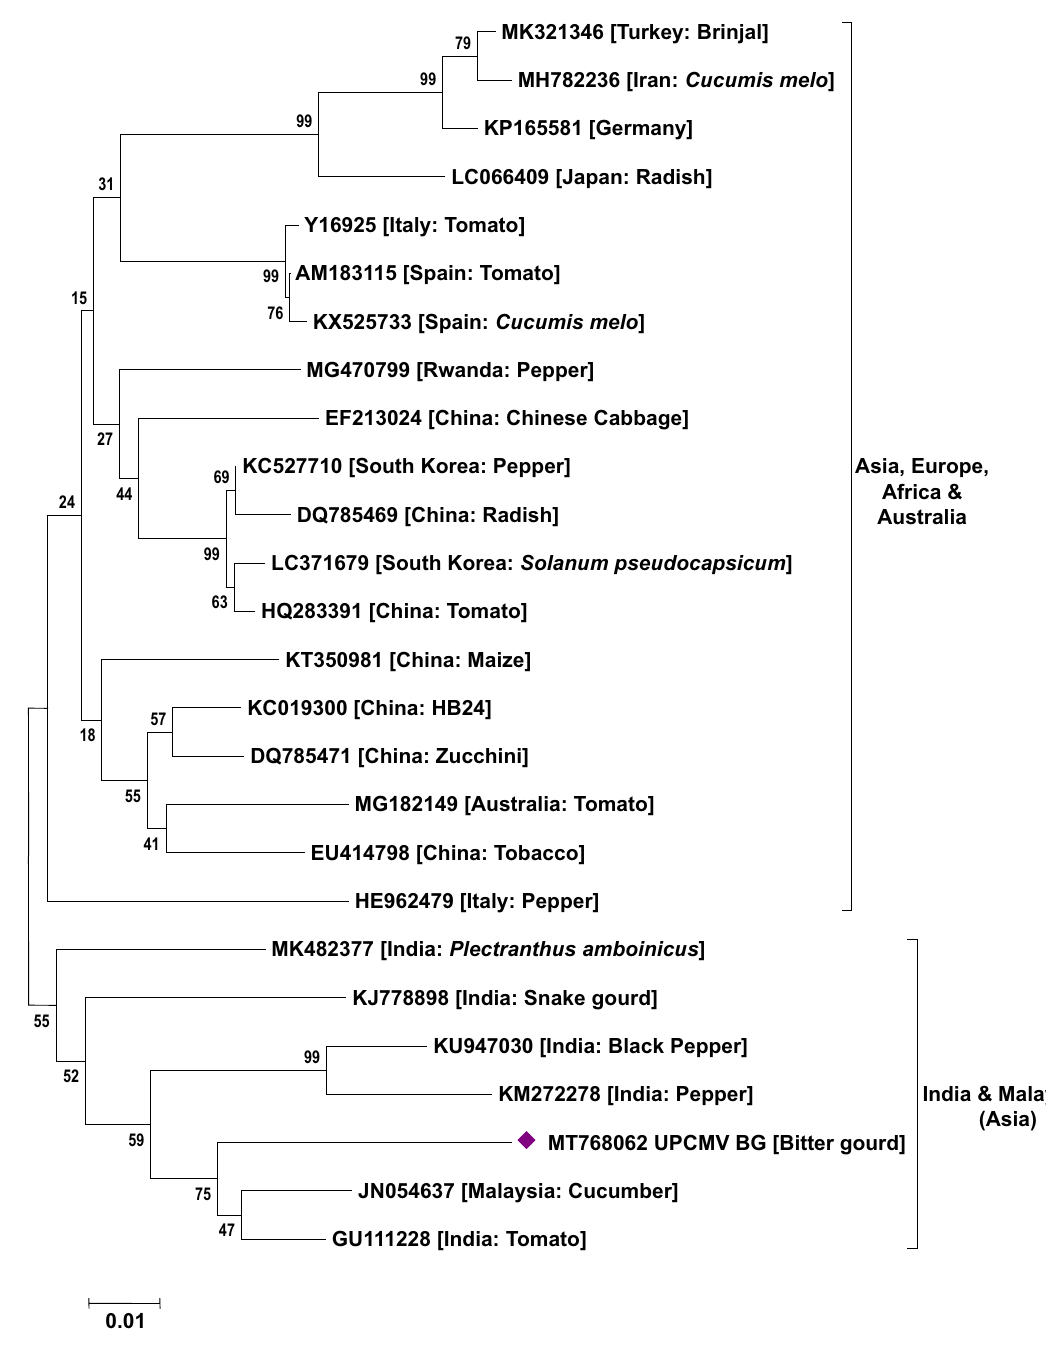
Figure 5. Phylogenetic analysis of ( a ) CMV infecting cucurbits in Uttar Pradesh state with other CMV isolates earlier reported based on 2a region. ( b ) CGMMV infecting cucurbits in Uttar Pradesh state with other CGMMV isolates reported earlier based on coat protein gene. ( c ) Potyviruses (PRSV and ZTMV) infecting cucurbits in Uttar Pradesh state with other earlier reported isolates based on Nib region. ( d ) PRSV infecting cucurbits in Uttar Pradesh state with other PRSV isolates reported earlier based on coat protein gene. ( e ) ZYMV infecting cucurbits in Uttar Pradesh state with other ZYMV isolates reported earlier based on coat protein gene. ( f ) WBNV infecting cucurbits in Uttar Pradesh state with other WBNV isolates reported earlier based on coat protein gene. ( g ) Poleroviruses infecting cucurbits in Uttar Pradesh state with other earlier reported isolates based on coat protein gene. Trees were generated with 1000 bootstrap replications using neighbour joining method in MEGA 7.0